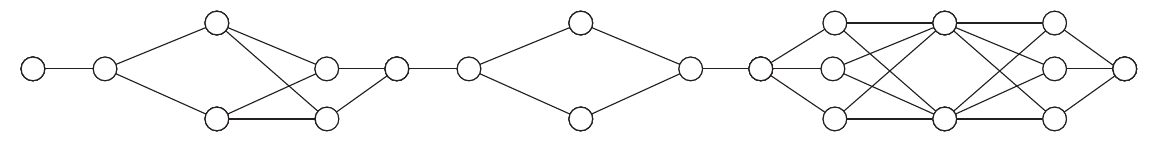
Figure 4: A 3 -semiregular bipartite graph G with M( G ) = Z( G